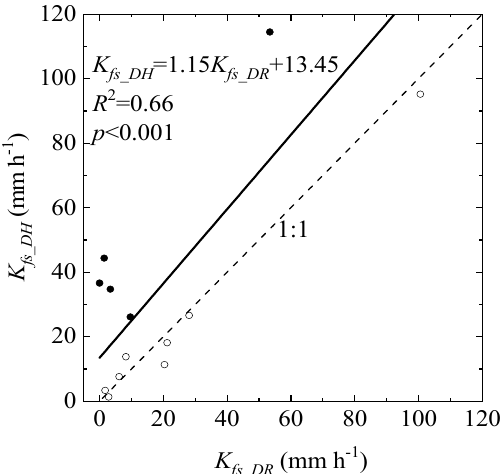
Figure 6. Relationship between field-saturated hydraulic conductivities measured concurrently by the DHI ( K fs_DH ) and DRI ( K fs_DR ). The solid dots indicate divergent measurements between the two methods, while the open dots, distributed along the 1:1 line (dashed), indicate similar results. All data were included in the regression line (solid). The equation, coefficient of determination ( R 2 ), and the significance value ( p ) are also shown for the all-data regression (solid line).